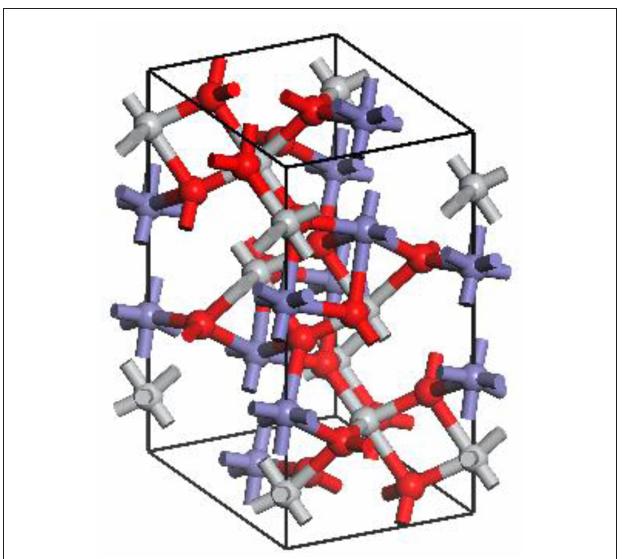
FIGURE 1 | Optimum ilmenite crystal. The red spheres represent O atoms, the gray represents Ti atoms, and the blue represents Fe atoms.